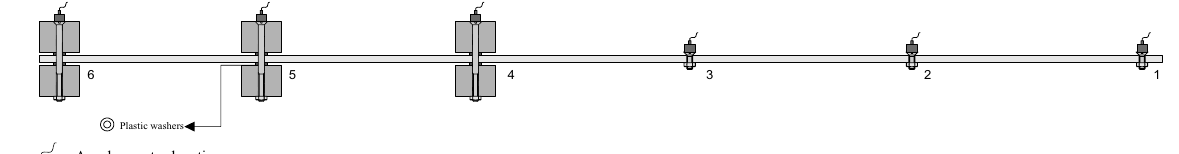
Fig. 1. Original structure.